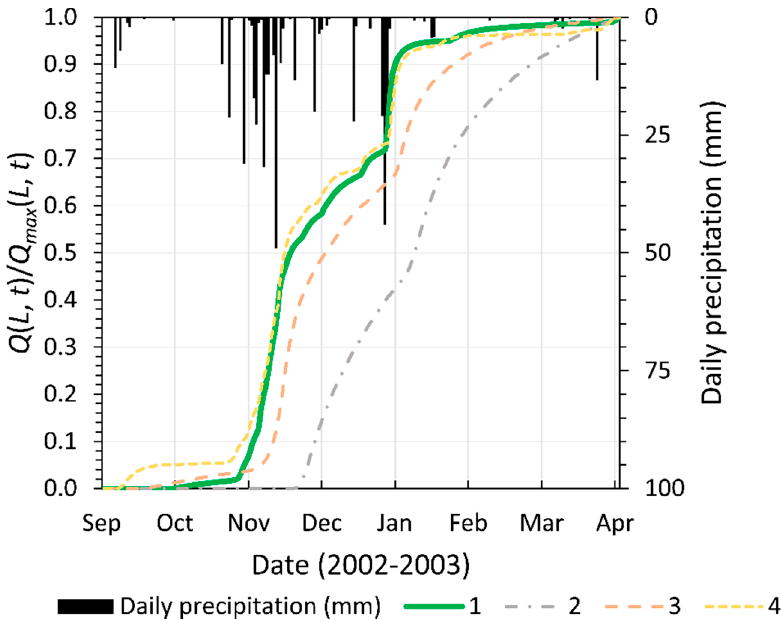
Figure 11. Relative infiltration at water table Q ( L , t )/ Q max ( L , t ). (1) Kinematic dispersion wave model solution with a = 3, b = 3.6 × 104 mmh − 1 and α w = 200 mm. Brooks and Corey-based Richards’ solution for: (2) silty clay soil with K s = 2.500 × 10 − 7 ms − 1 , θ s = 0.479 m 3 /m 3 , θ r = 0.056 m 3 /m 3 , h d = 0.342 m, n = 0.127; (3) silty soil with K s = 1.889 × 10 − 6 ms − 1 , θ s = 0.501 m 3 /m 3 , θ r = 0.015 m 3 /m 3 , h d = 0.207 m, n = 0.211; (4) sandy soil with K s = 1.157 × 10 − 3 ms − 1 , θ s = 0.437 m 3 /m 3 , θ r = 0.020 m 3 /m 3 , h d = 0.146 m, n = 0.520.